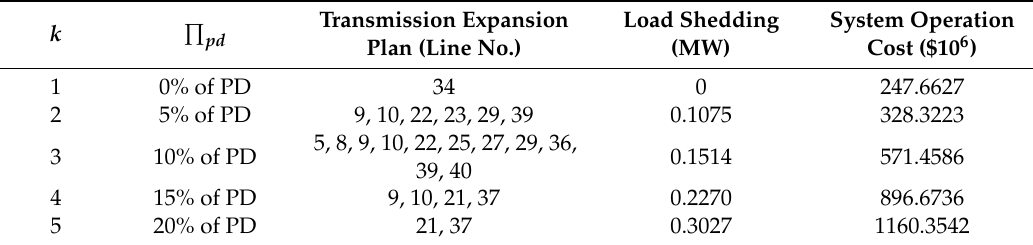
Table 2. IEEE 30-bus power system: Robust sole transmission